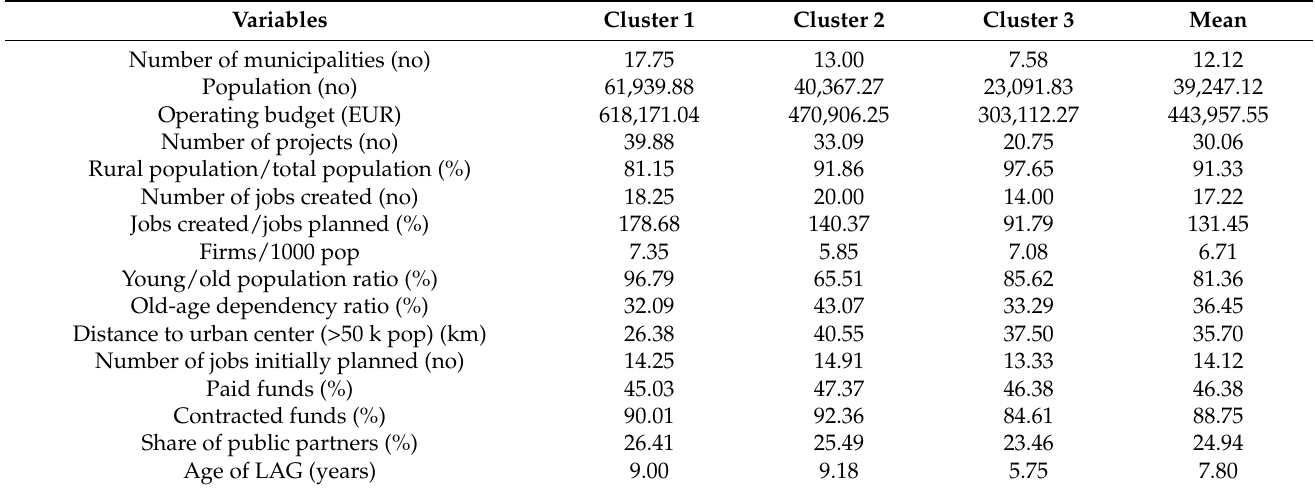
Table 3. Hierarchical cluster analysis results.